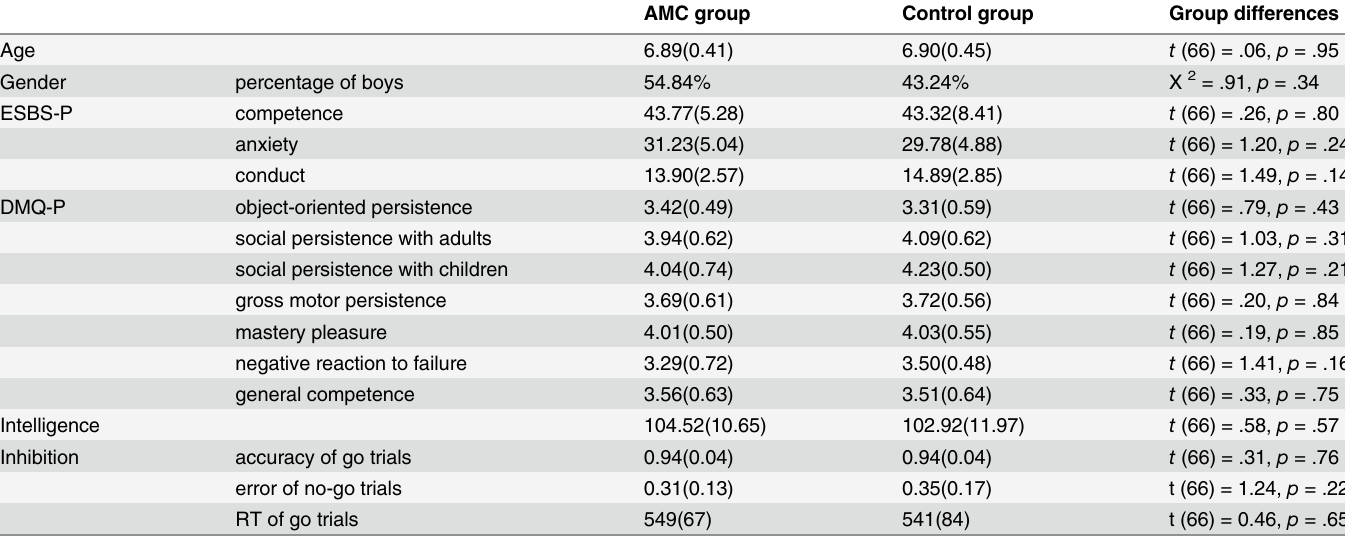
Table 1. Baseline comparisons for the two